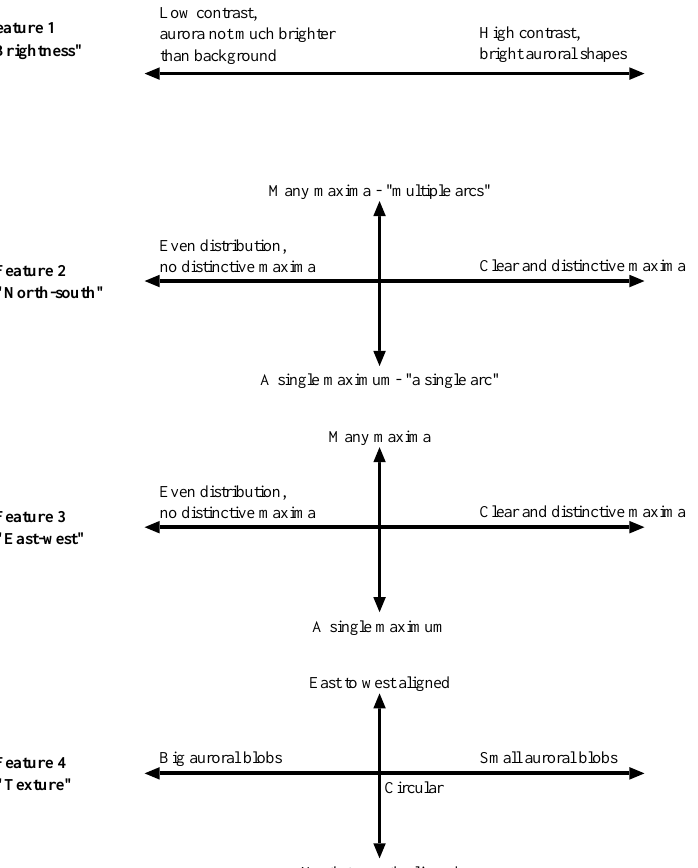
Fig. 6. Qualitative interpretation of the features. Feature 1 measures the over- all contrast and distinctiveness of au- rora in the image. Features 2 and 3 provide information about the distribu- tion of the aurora – a clear maximum in north-south distribution, combined with an even distribution in east-west direc- tion, usually represents an auroral arc. Similarly, many peaks presumably cor- respond to multiple arcs. Feature 4 is a proxy to “patchyness” or the size and shape of auroral blobs in the